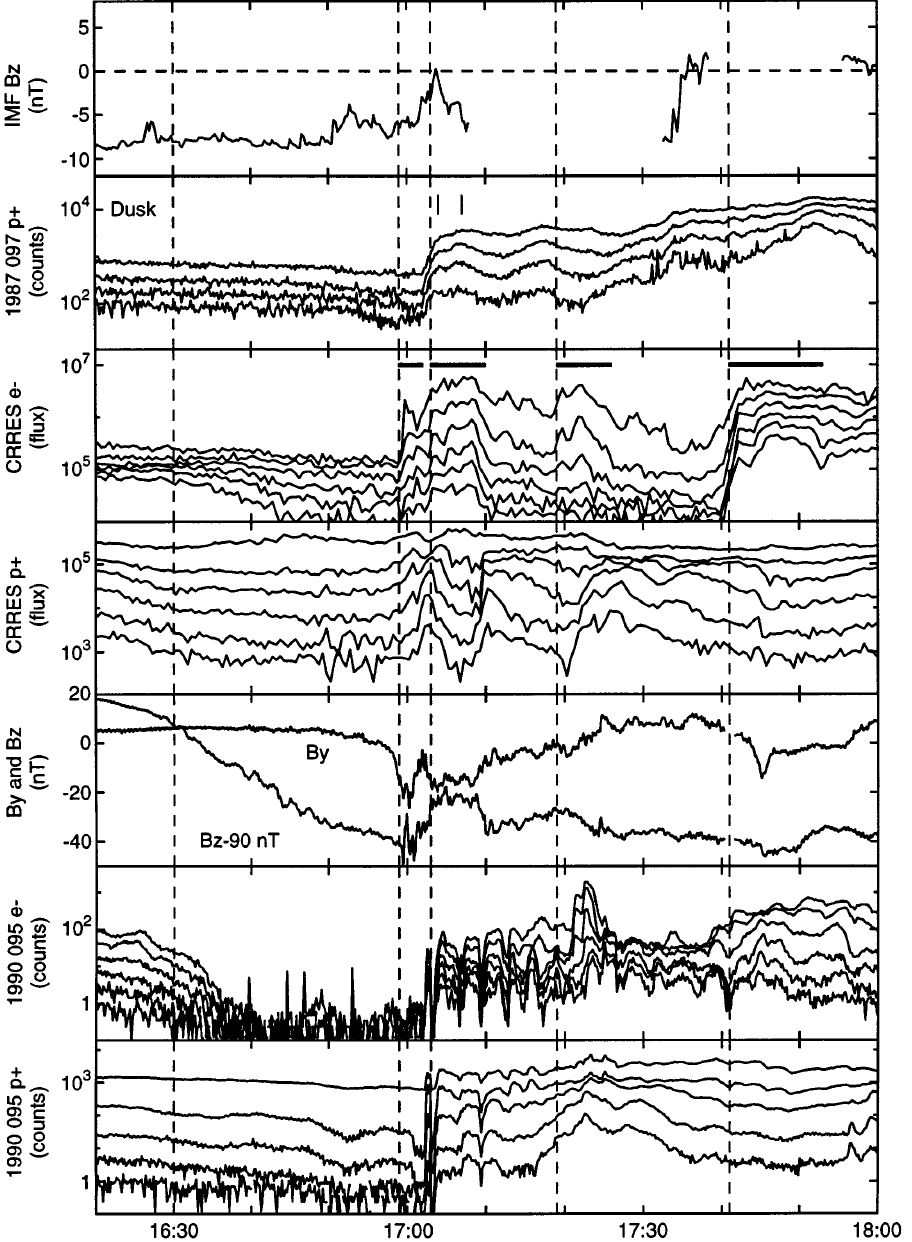
than available in Fig. 3. The di(cid:128)erent panels contain 90 (cid:14)